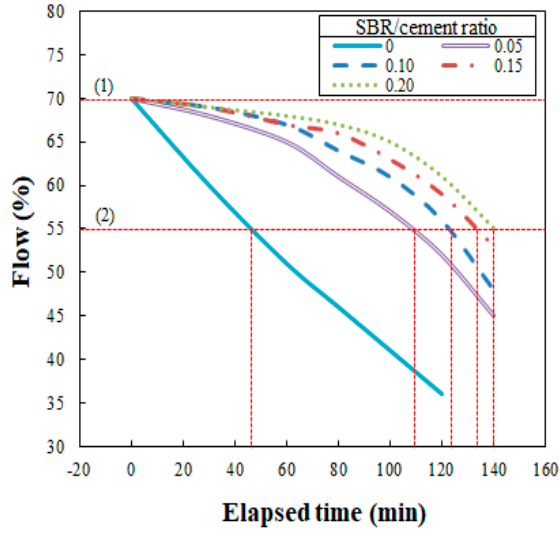
Figure 10. Delay time versus flow, used in finding the open time.